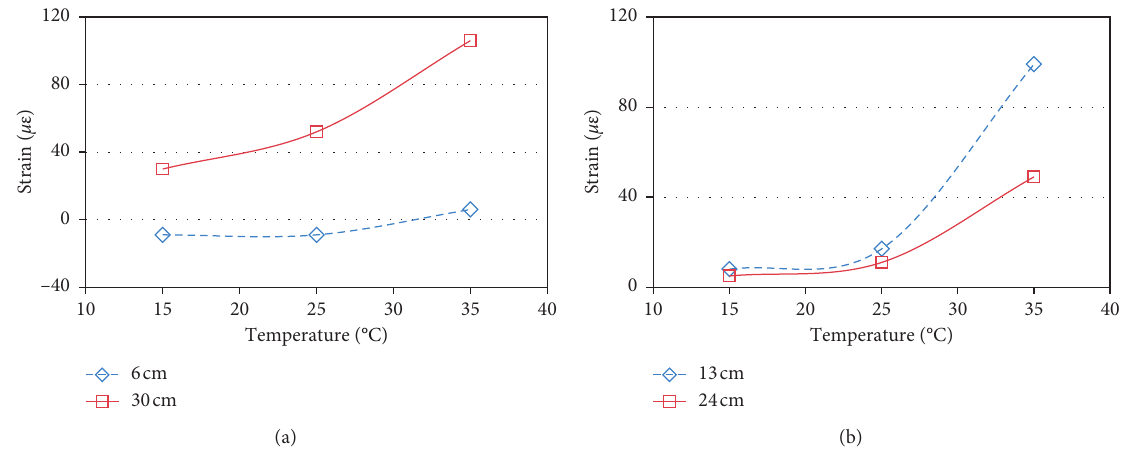
Figure 9: The strain values under FWD loading at different temperatures for (a) flexible pavement and (b) semirigid